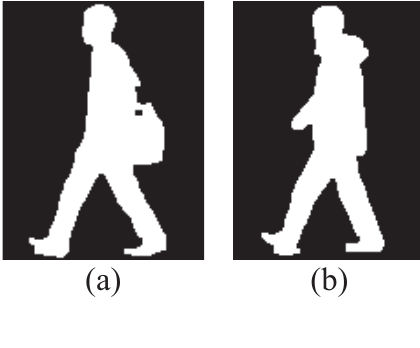
Figure 9. Examples of silhouette images: ( a ) CASIA-B-BG and ( b ) CASIA-B-CL.